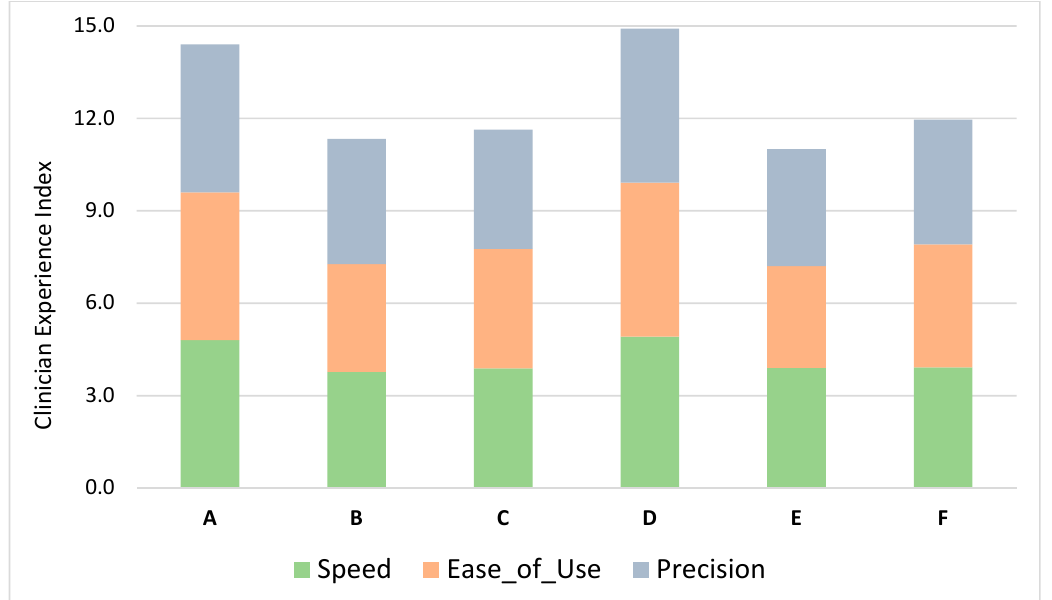
Figure 3. Clinician Experience Index. Individual clinicians (n = 6) are presented on the x-axis while the sum of the 5-point scales for speed, ease of use, and precision is presented on the y-axis.